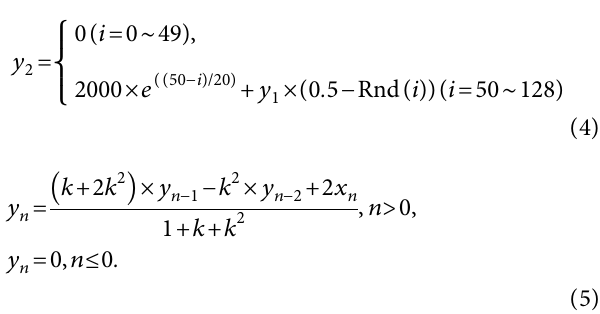
Figure 7: Amplitude spectrum distribution of analog and digital engineering cost data signal (original signal+ digital S – K shaping).